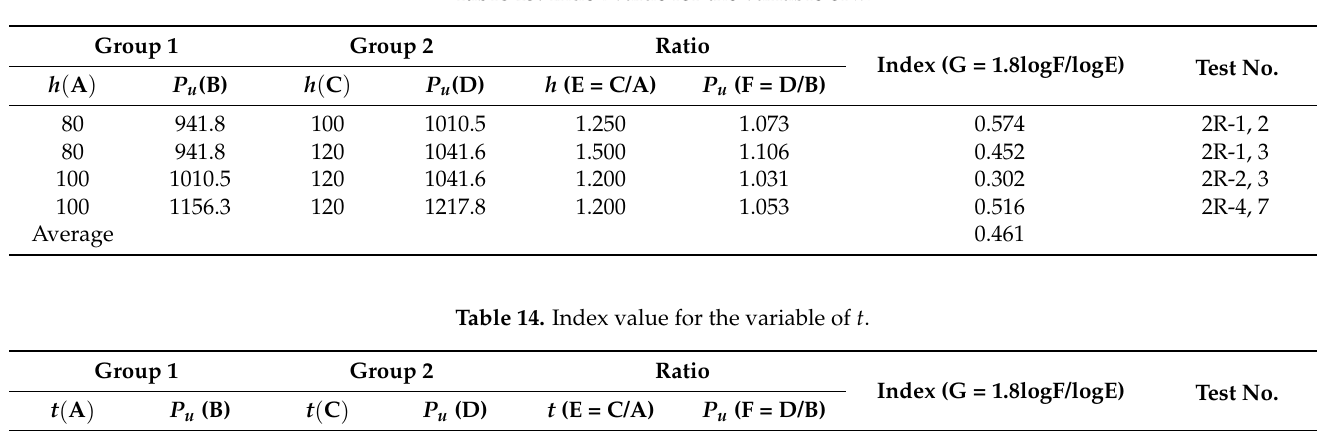
Table 13. Index value for the variable of h .